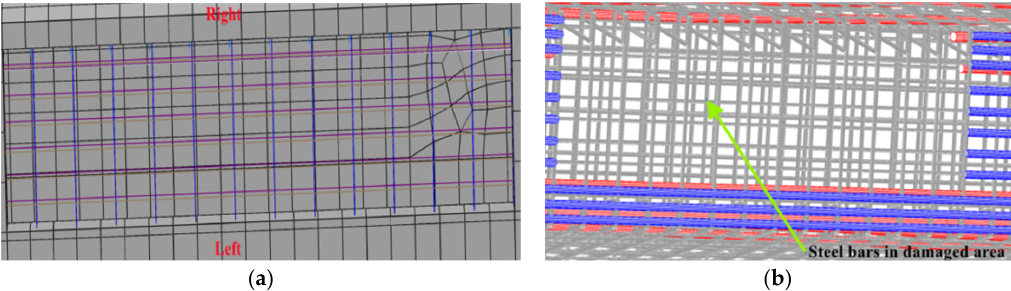
Figure 16. Details in the damage region of the box girder. ( a ) Concrete fell off; ( b ) Posttensioned